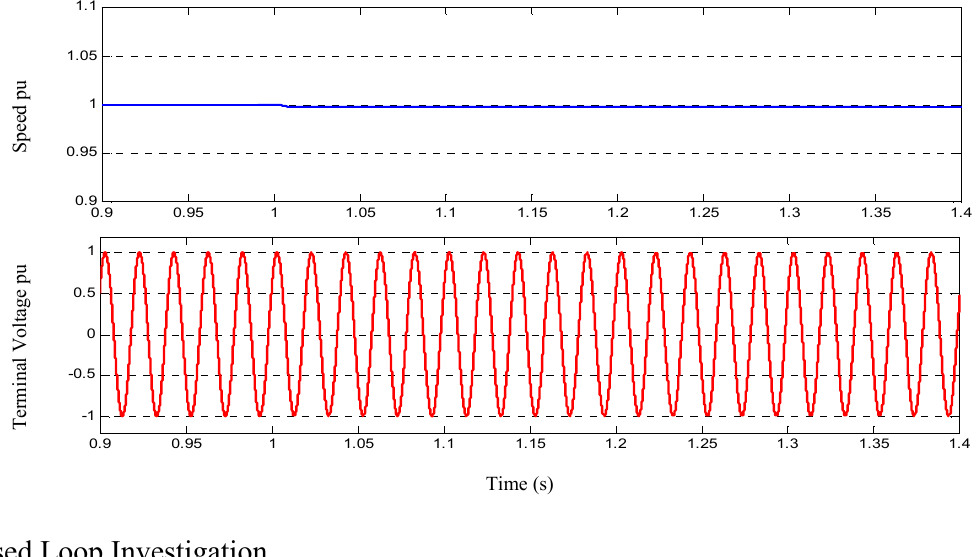
Figure 12. The machine islanded with optimum active and reactive